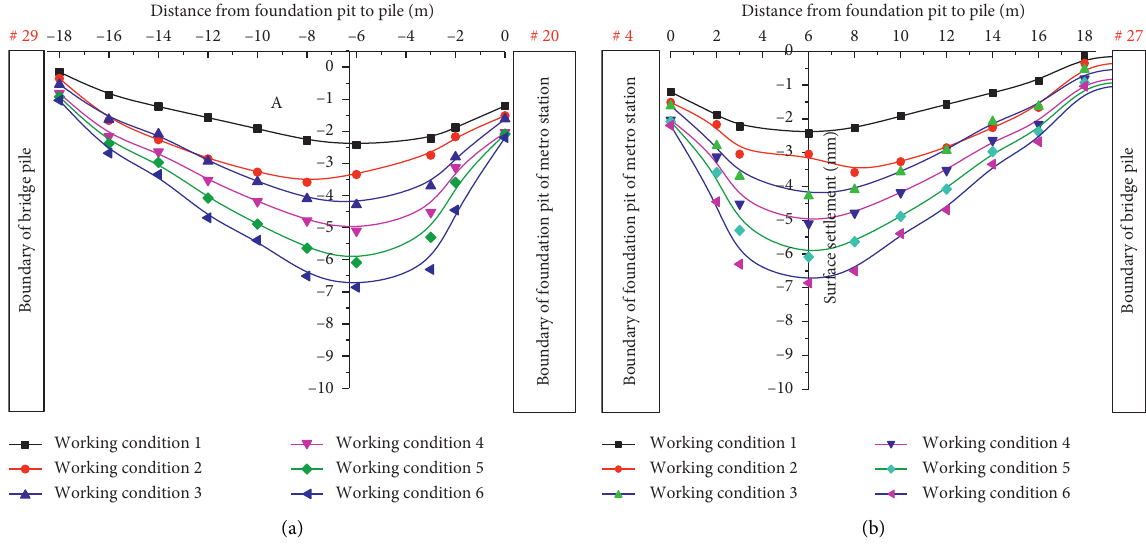
Figure 12: Surface settlement curves under different working conditions. (a) Line 29–20. (b) Line 4–27.